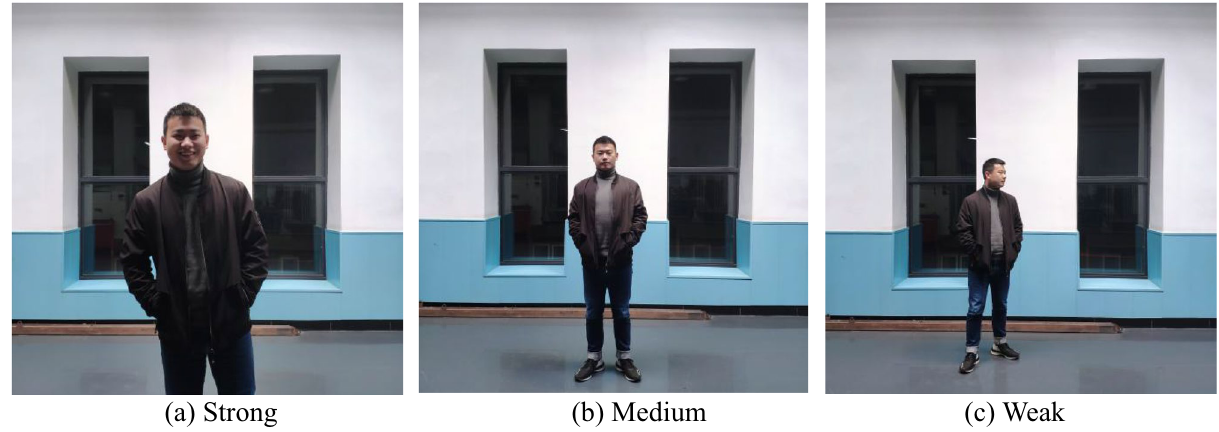
Figure 5. Hierarchy of IHEI among participants. The IHEI is divided into three levels: strong, medium and weak.